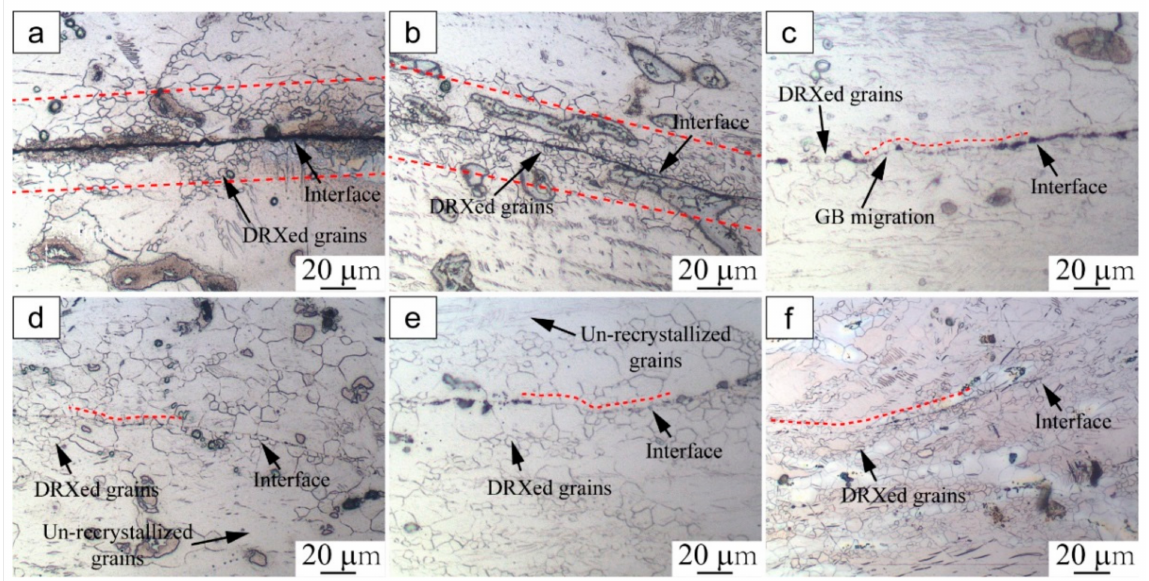
Figure 2. Microstructure around the bonding interface of specimens compressed at 350 ◦ C under different strains: ( a ) 0.1, ( b ) 0.2, ( c ) 0.3, ( d ) 0.4, ( e ) 0.5, ( f )